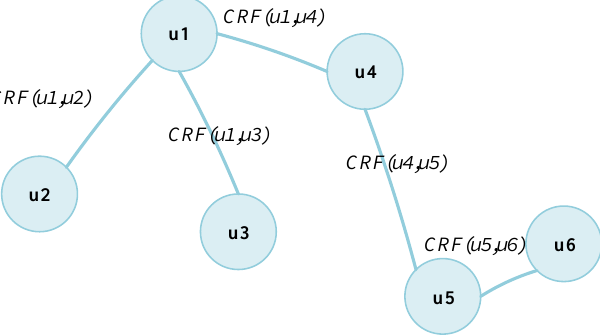
Figure 2. Simple Schematic Diagram of User Collusive Relationship Graph.